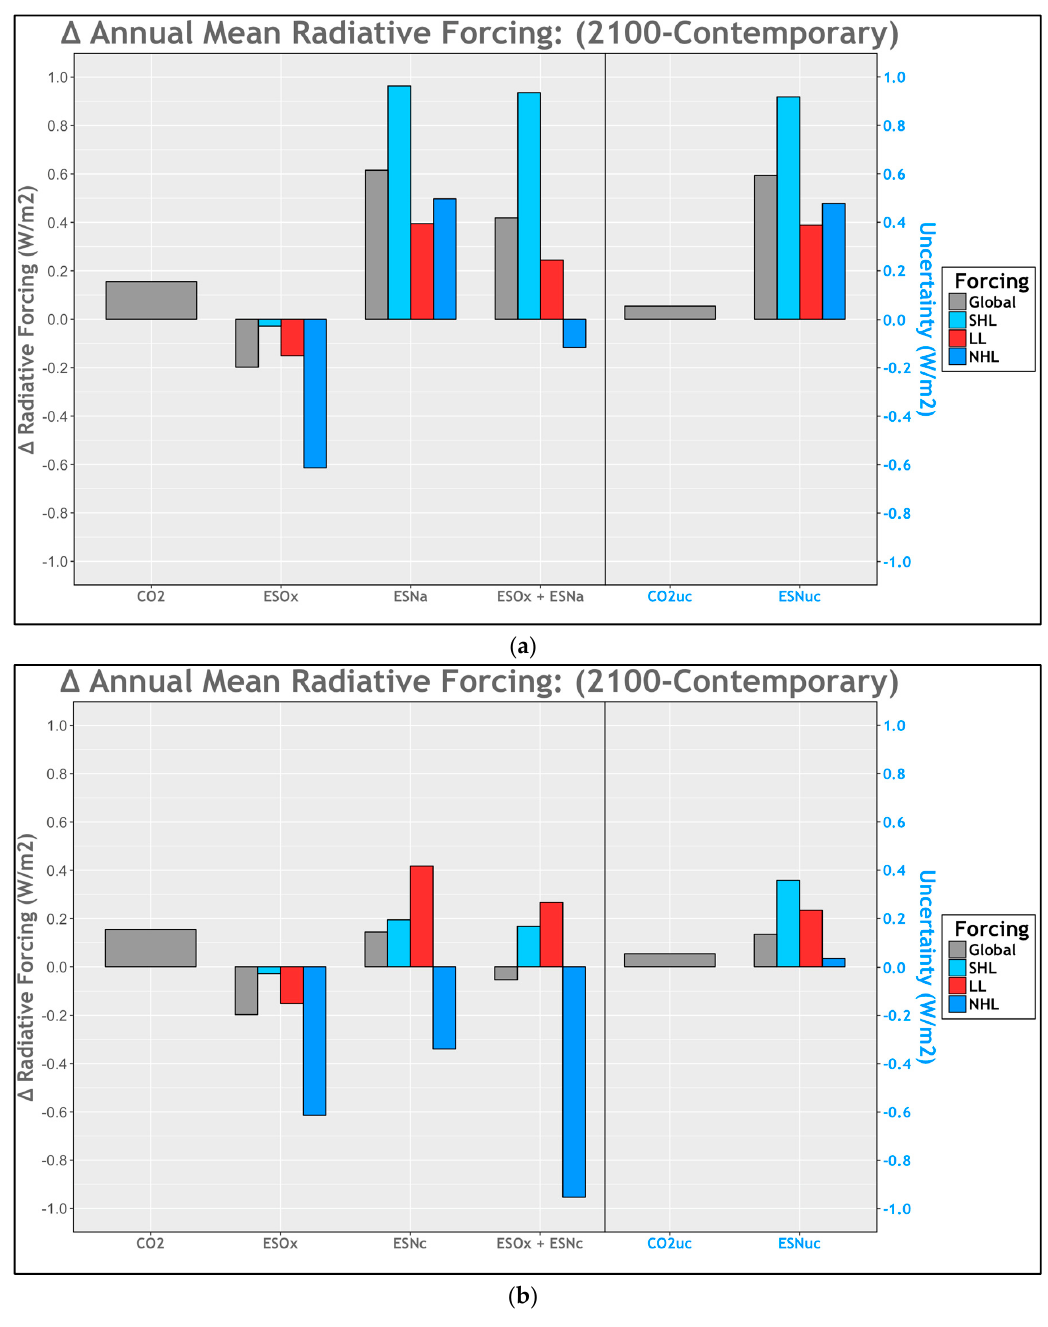
Figure 3. Results from the investigation are shown in histogram format. Representative global (gray) and regional changes—southern high latitude (SHL: 90–30° S) (light blue), low latitude (LL: 30–30° N) (red), northern high latitude (NHL: 30–90° N) (blue). Included in order: the change in radiative forcing from CO 2 mBGC feedback (CO 2 ), anthropogenic SO 2 (ESO x ), natural sulfur (ESN), combined man-made and natural sulfur (ESO x + ESN), CO 2 uncertainty (CO 2 uc), and natural sulfur uncertainty (ESNuc): ( a ) results with respect to ocean acidification; ( b ) findings from our examination of planktonic community shifts.